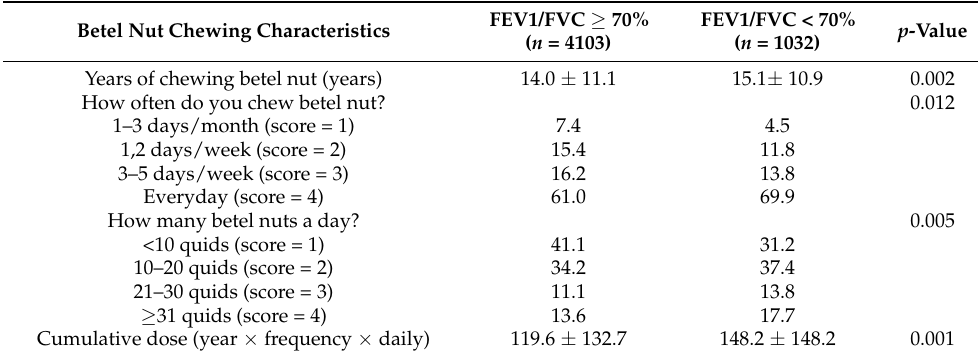
Table 3. Comparison of betel nut chewing characteristics among participants with betel nut chewing history according to FEV1/FVC ≥ 70% or